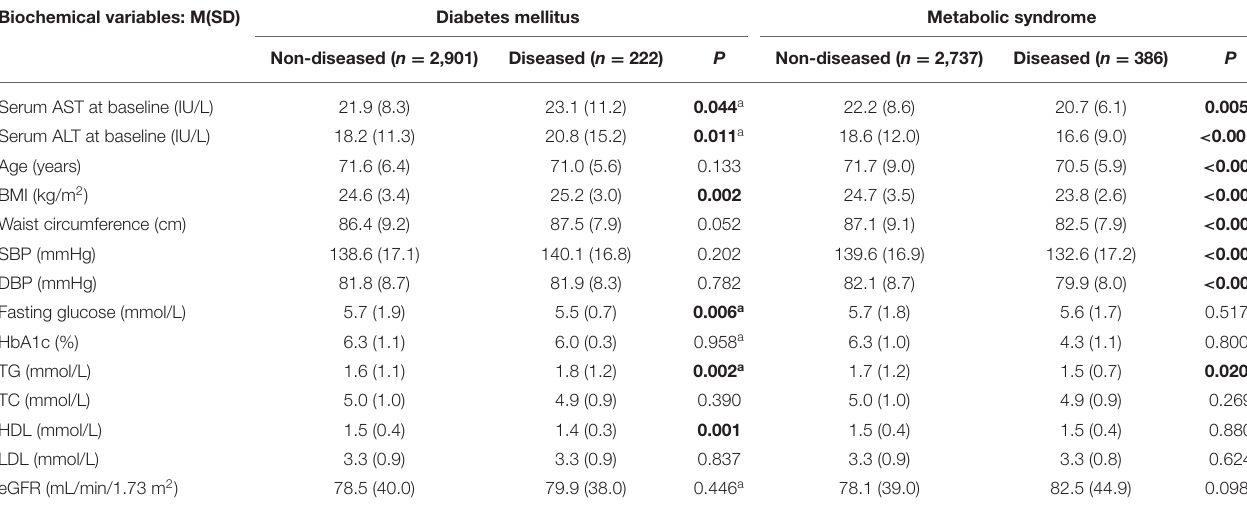
TABLE 2 | Biochemical variables associated with disease status at follow-up. Biochemical variables: M(SD)